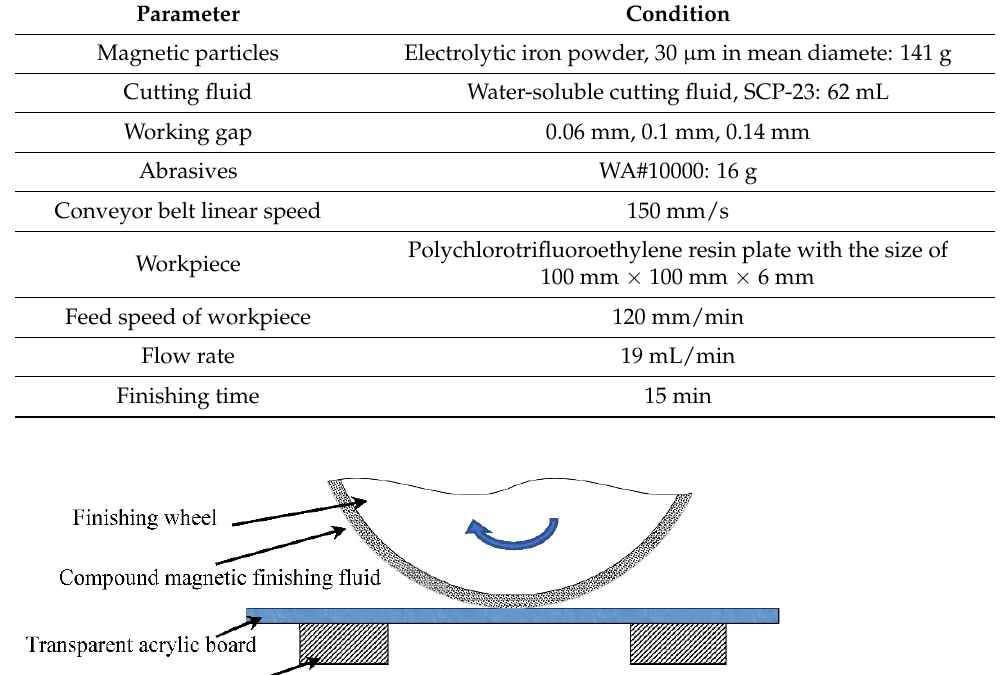
Table 3. Experimental conditions.